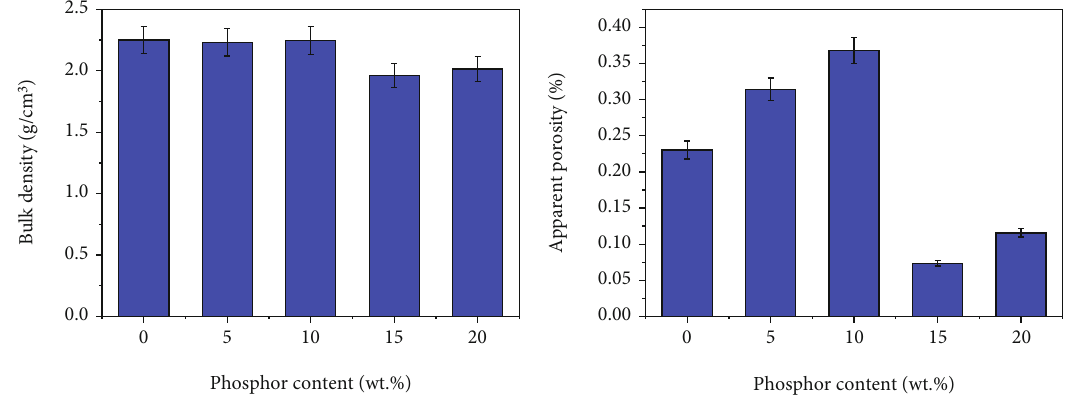
Figure 2: Bulk density and apparent porosity of phosphor-in-glass ceramic aggregates with varying phosphor